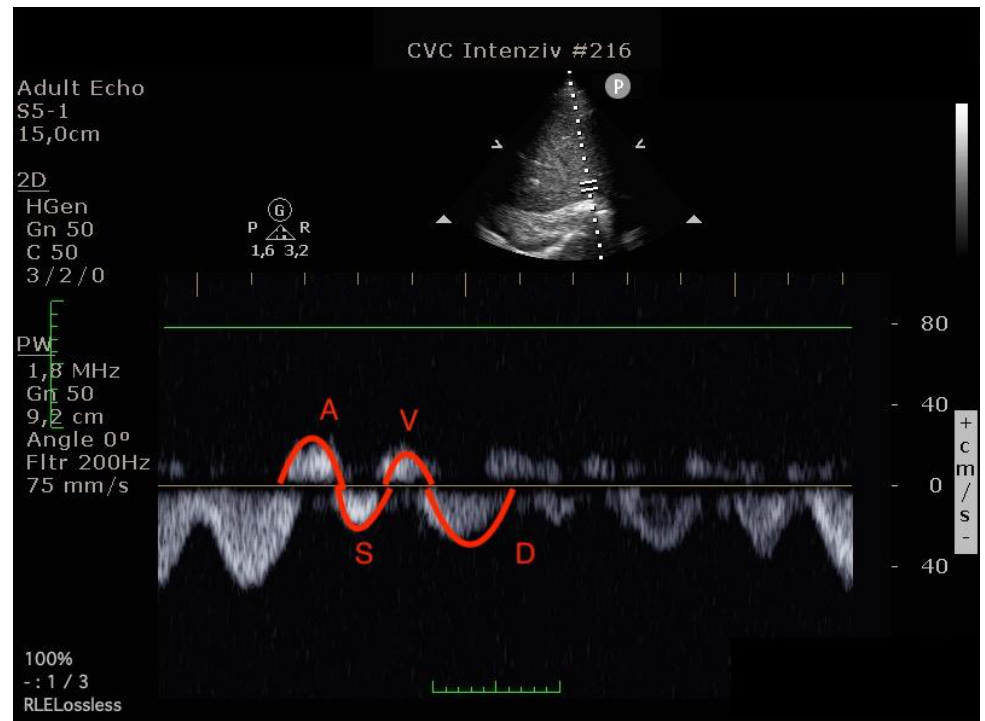
Figure 4. Hepatic venous flow pattern (The left image was done before operation, the right image in the postoperative 24th hour. On the postoperative image, A and V waves appear increased, while the S wave is smaller than the D wave. (A VTI: 6.47 to 8.29, S VTI: 12.31 to 8.12, V VTI: 5.98 to 7.98 and D VTI: 11.12 to